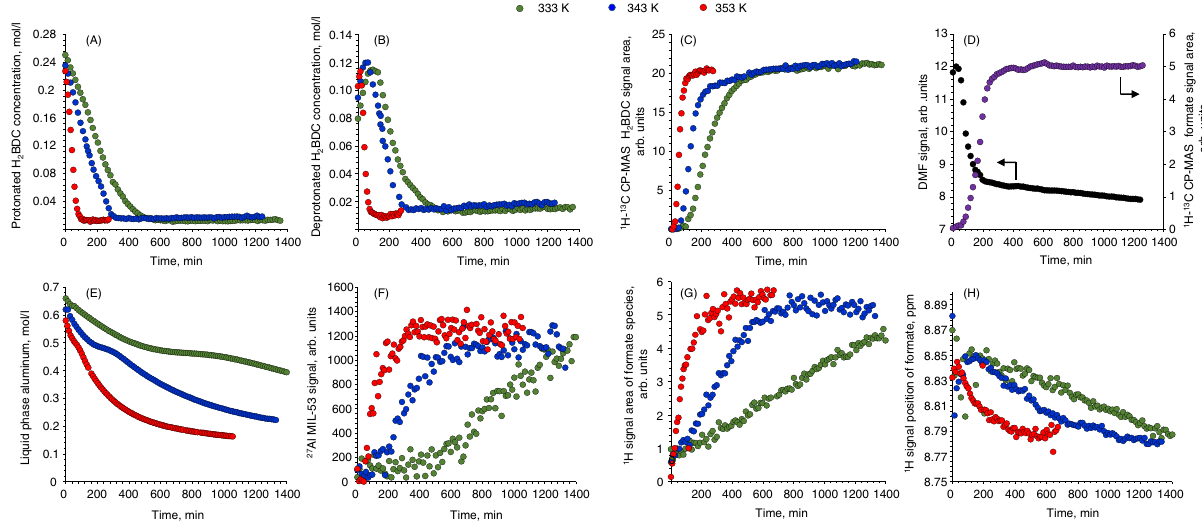
Fig. 3 Analysis of time-resolved NMR spectra series. Concentration of ( A ) protonated and ( B ) deprotonated carboxyl group in terephthalic acid obtained from 13 C MAS NMR spectra; temporal evolution of 1 H- 13 C CP-MAS signals of ( C ) terephthalate and ( D ) formate species in solid nuclei of MIL-53 together with the 13 C DMF signal intensity; ( E ) concentration of aluminum species in solution versus synthesis time; ( F ) time-resolved response of the integral intensity of the MIL-53 spinning side band centered at − 150 ppm; ( G ) integral intensity and ( H ) position of 1 H signal due to the formate species in solution. Colured circled encode reaction temperature except in ( D